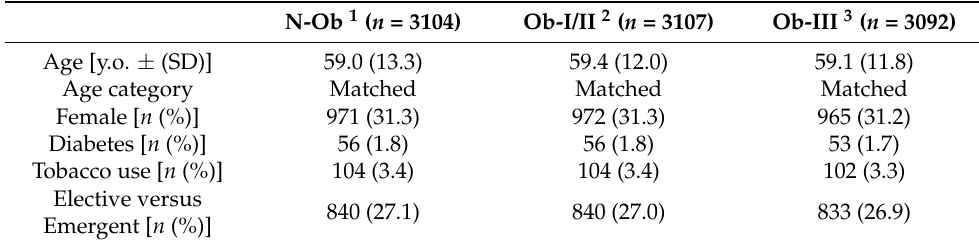
Table 1. Patient demographics in patients undergoing below-the-knee amputations.